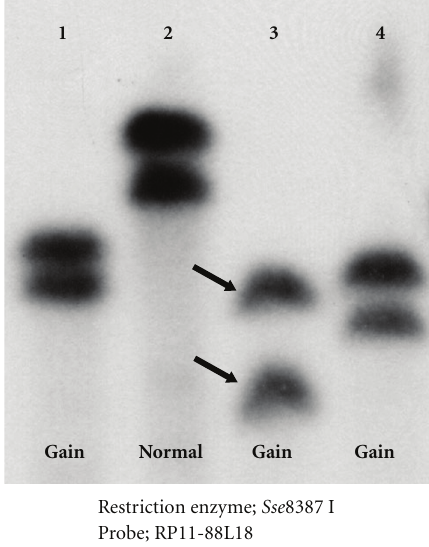
Figure 2: Typical patterns of CNVs detected on the BAC clone (RP11-88L18) from Southern blot analyses after PFGE. Very complicated segmental duplication patterns are present in the region of this BAC clone. The electrophoresis pattern showed the complicated patterns according to the segmental duplication. When the fragment length of the “Gain” (lanes; 1, 2, 4) was compared with “Normal” (lane 3), the segment sizes of the three (lanes; 1, 2, 4) individuals were larger than those (shown by arrows) of “Normal.” That is, as those three contained a larger number of core segments, the signals on the BAC spot were stronger than normal. So, those three were identified as